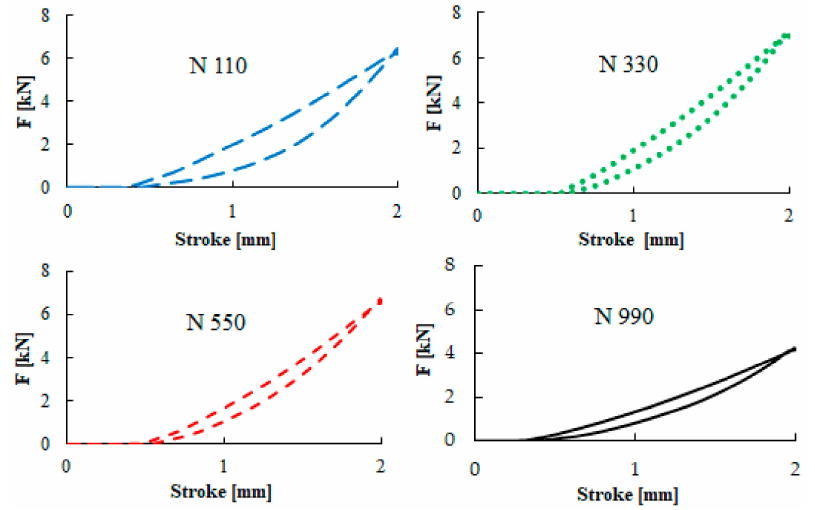
Figure 11. Hysteresis images of four carbon black